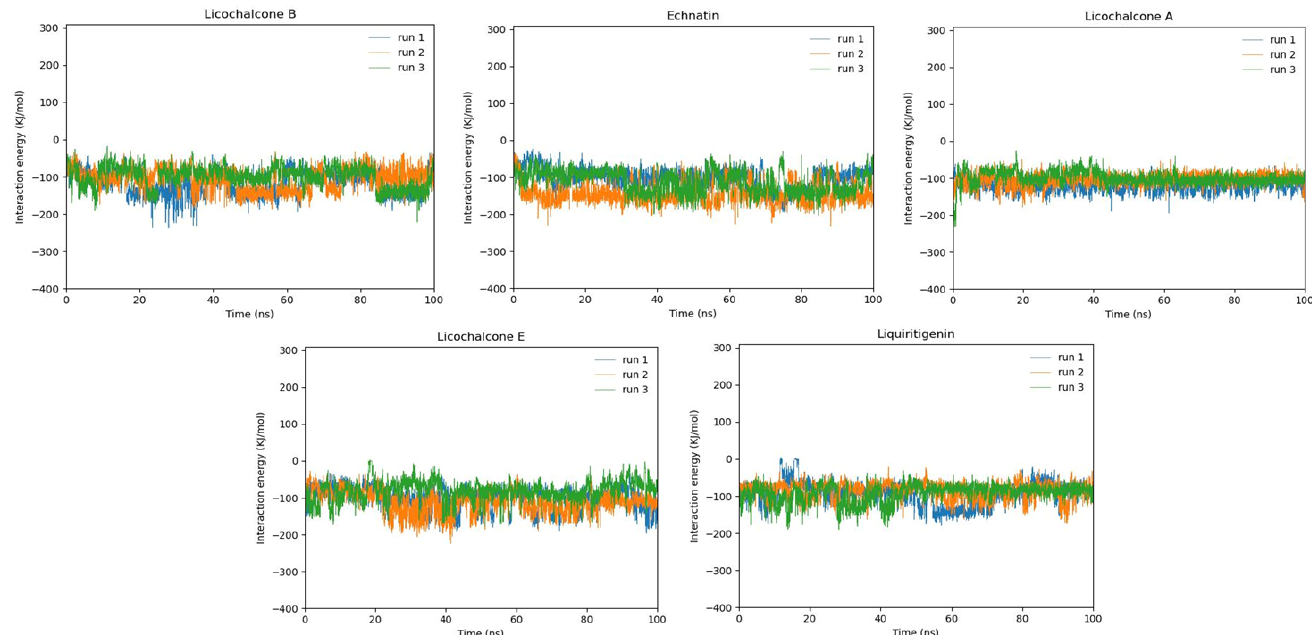
Figure 12. Bar graph depicting the stability of total interaction energy for licochalcone B, echinatin, licochalcone A, licochalcone E, and liquiritigenin for all three runs of 100 ns. Every run is indicated by a different color (run1—blue, run2—orange, run3—light green). The triplicates of every compound were predicted separately.